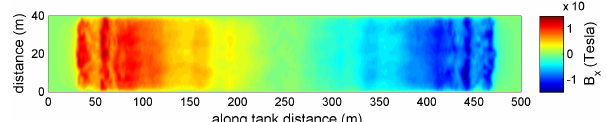
Figure 9. Signature of the low-density buoyancy-driven current in the induced magnetic field ( x component) at 1m below the surface at time t = 2850s.